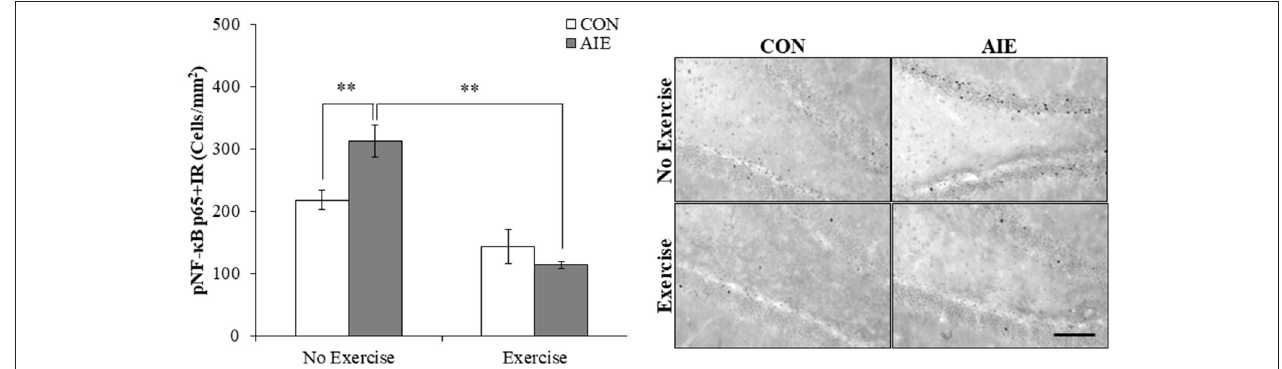
FIGURE 6 | Voluntary wheel running prevented the adolescent intermittent ethanol (AIE)-induced phosphorylation of the proinflammatory transcription factor nuclear factor kappa-light-chain-enhancer of activated B cells p65 (phosphorylated [pNF- κ B p65]) in the adult hippocampal dentate gyrus. Modified unbiased stereological quantification of pNF- κ B p65 + IR cells revealed a 40% ( ± 12%) increase in the adult (P80) hippocampal dentate gyrus of AIE-treated animals, relative to CONs. Interestingly, subjects in the AIE treatment group that were exposed to voluntary wheel running from P24 to P80 did not evidence the observed increase of pNF- κ B p65 + IR cells, relative to AIE animals. Representative photomicrographs of pNF- κ B p65 + IR cells in the adult hippocampal dentate gyrus from CON- and AIE-treated animals across exercise conditions. Scale bar = 100 µ m. Data are presented as mean ± SEM. ** p < 0.01.